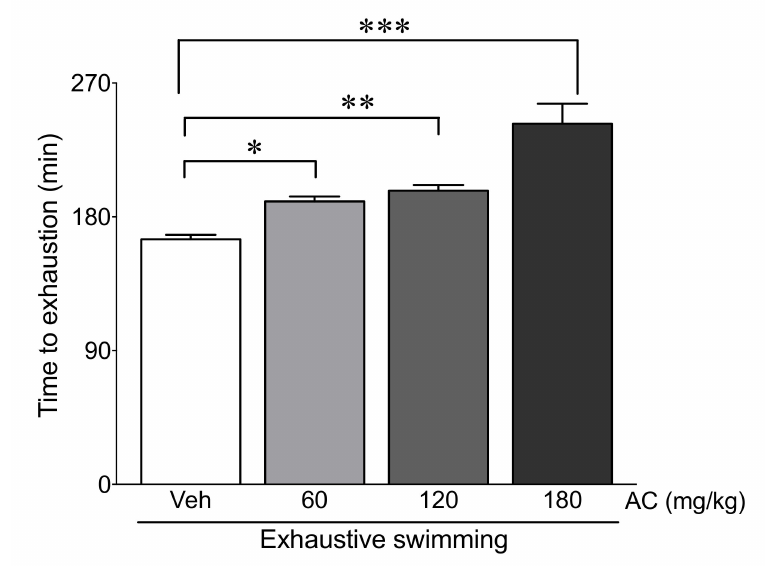
Figure 2. AC extract treatment enhanced the exercise duration of rats during exhaustive swimming. Exhaustion time was measured in rats after AC-pre-treatment for three weeks ( n = 10 per group). Data are mean ± standard error of mean (SEM). Significance was measured using one-way analysis of variance (ANOVA) followed by Bonferroni’s post hoc test. * p < 0.05, ** p < 0.01, and *** p < 0.001. Veh, vehicle-treated; 60, 120, and 180 AC, 60, 120, 180 mg / kg AC extract-treated groups, respectively. AC, Aralia continentalis kitagawa extract.